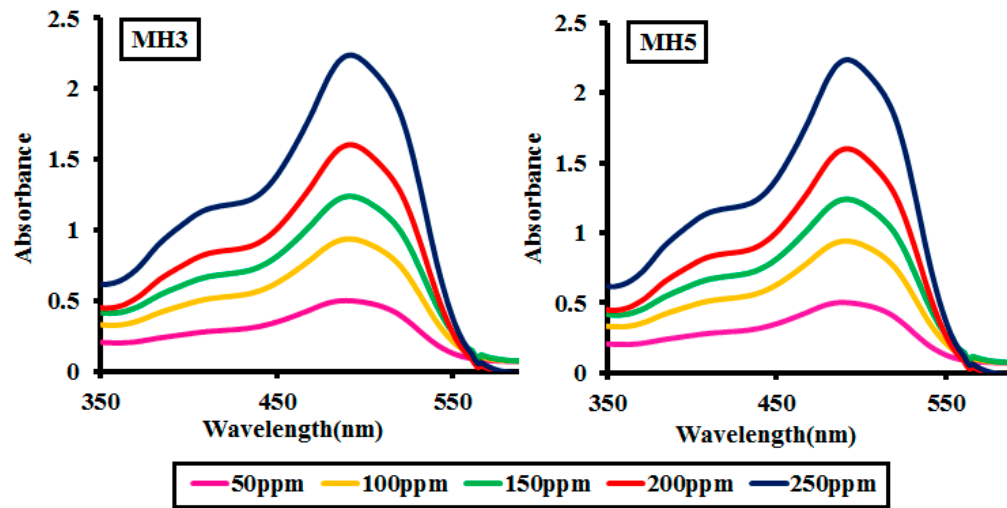
Table 7. Photocatalytic degradation of different concentrations (50–250 ppm) of alizarin red (AR) dye by MH1–MH5 (0.025 g) after 60 min of photocatalytic activity.